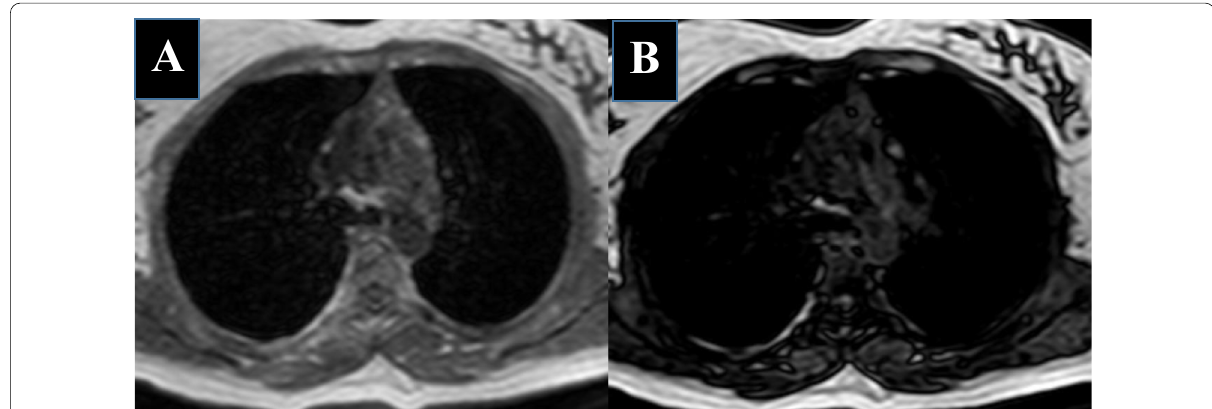
Fig. 7 MRI chemical shift imaging in a 44‑year‑old female patient complaining of drooping of both eyelids diagnosed as MG. a In phase and b out of phase MR images show the lesion eliciting a hyperintense signal relative to the surrounding muscles in the in‑phase series with apparent signal drop in the out of phase series. CSR value is 0.41. Histopathological diagnosis was thymic